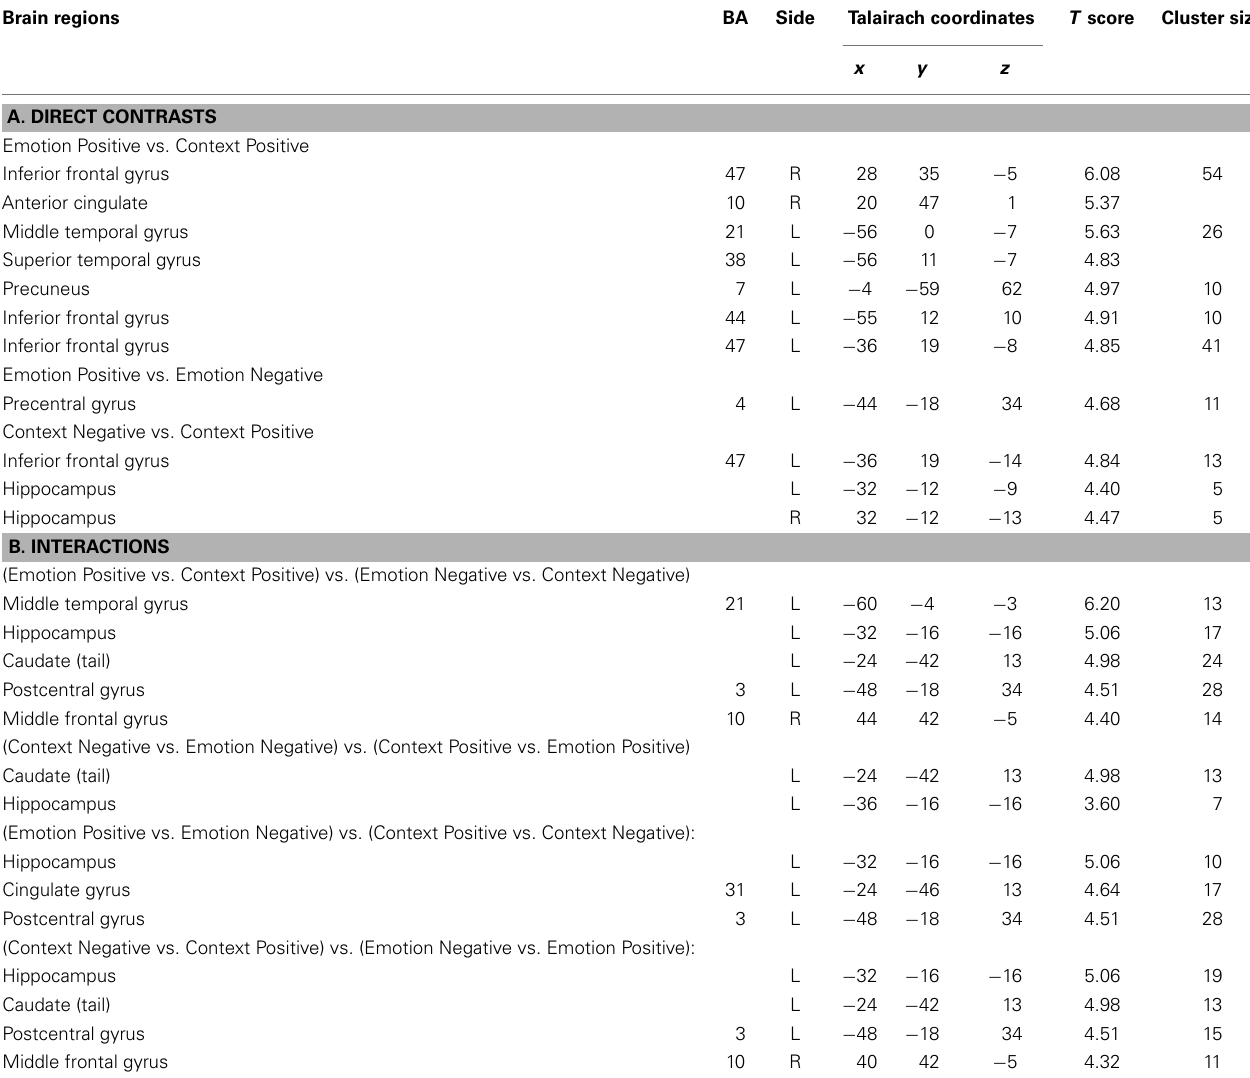
Table 3 |Whole-brain activations linked to retrieval focus and valence of